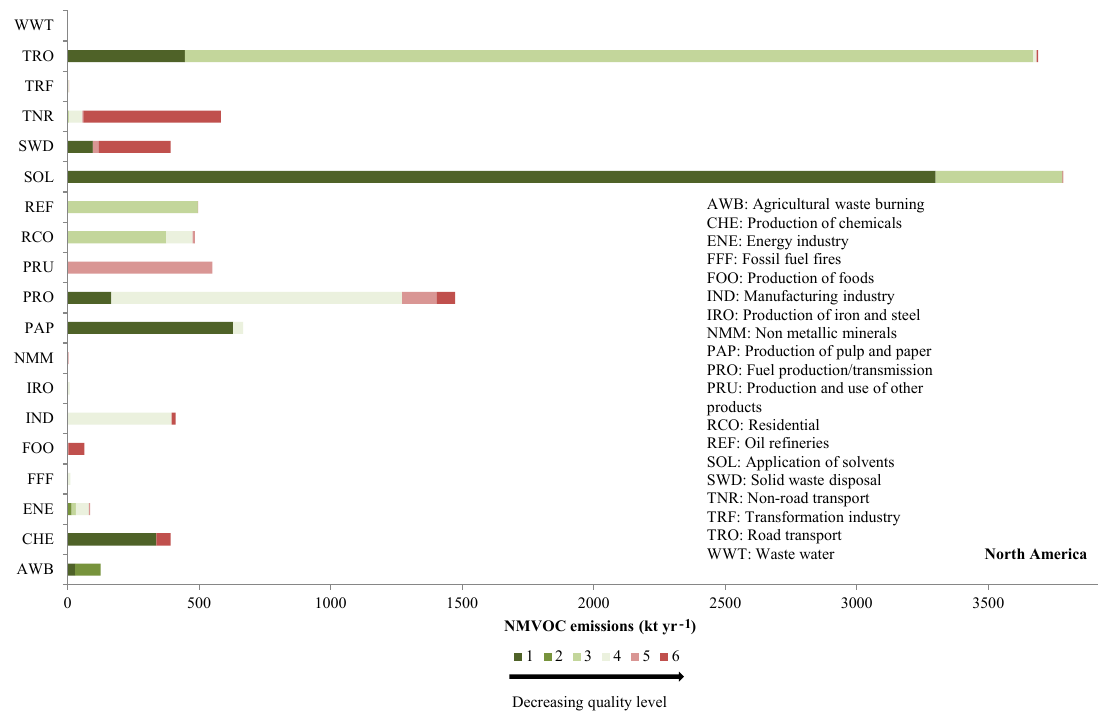
Figure 10. NMVOC emissions of different sources associated with each quality code in 2010 in North